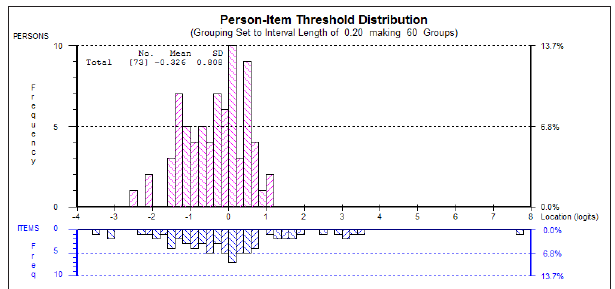
FIGURE 16: Person item threshold distribution